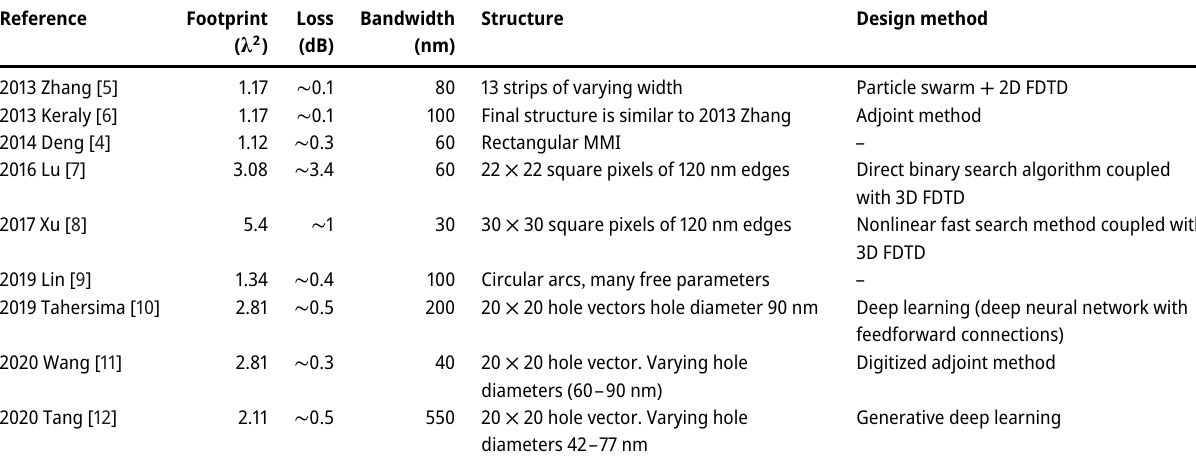
Table 1: Previous designs of compact equal power photonic Y-junctions on the standard single mode silicon-on-insulator platform with a silicon thickness of 220 nm. The table is compiled using the reported values from Refs. [5–13]. The footprint is defined as the rectangular area that encapsulates the maximum extents of the